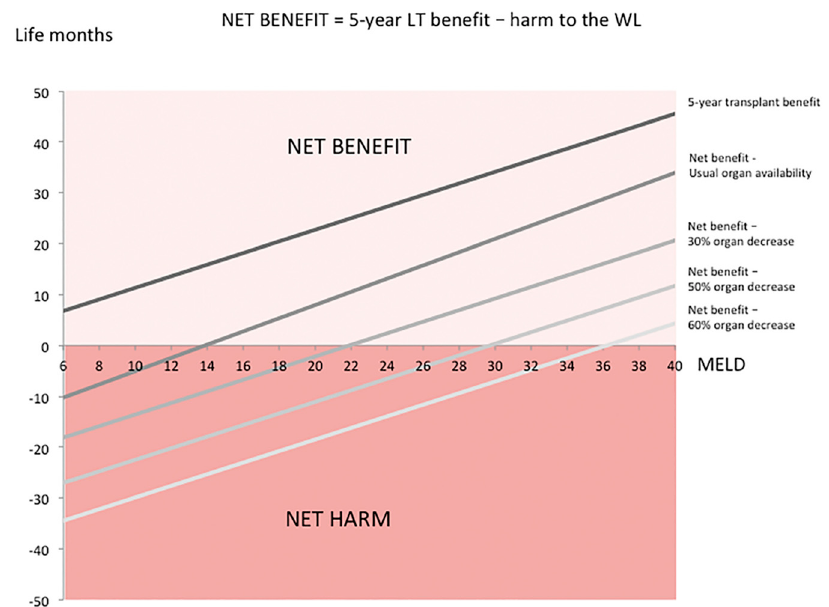
Figure 5. Net benefit (individual transplant benefit minus harm to others on the WL) estimation of LT in a T2 HCC patient in situations of usual organ availability and 50% decrease in organ availability compared to individual five-year transplant benefit estimation.